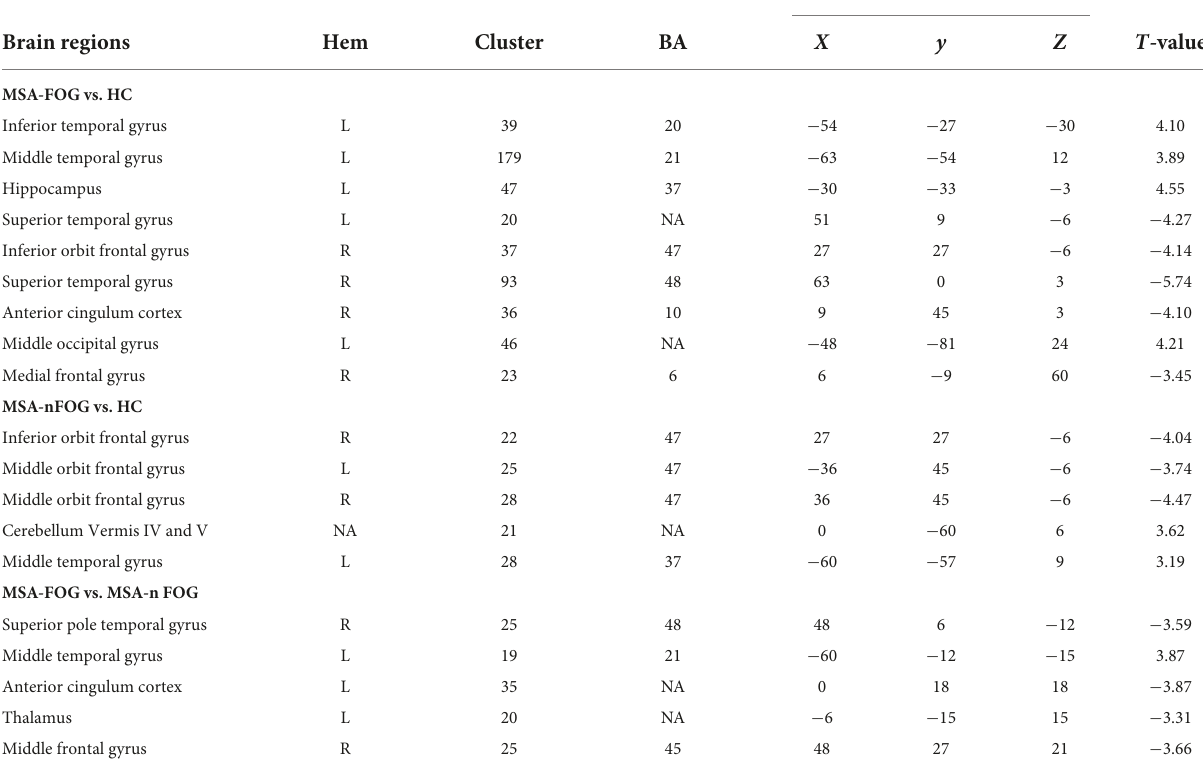
TABLE 2 Brain area differences in degree centrality between patients with MSA and HC.